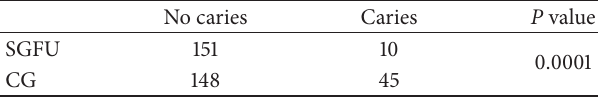
Table 1: Chi-square analysis of caries in the SGFU and the